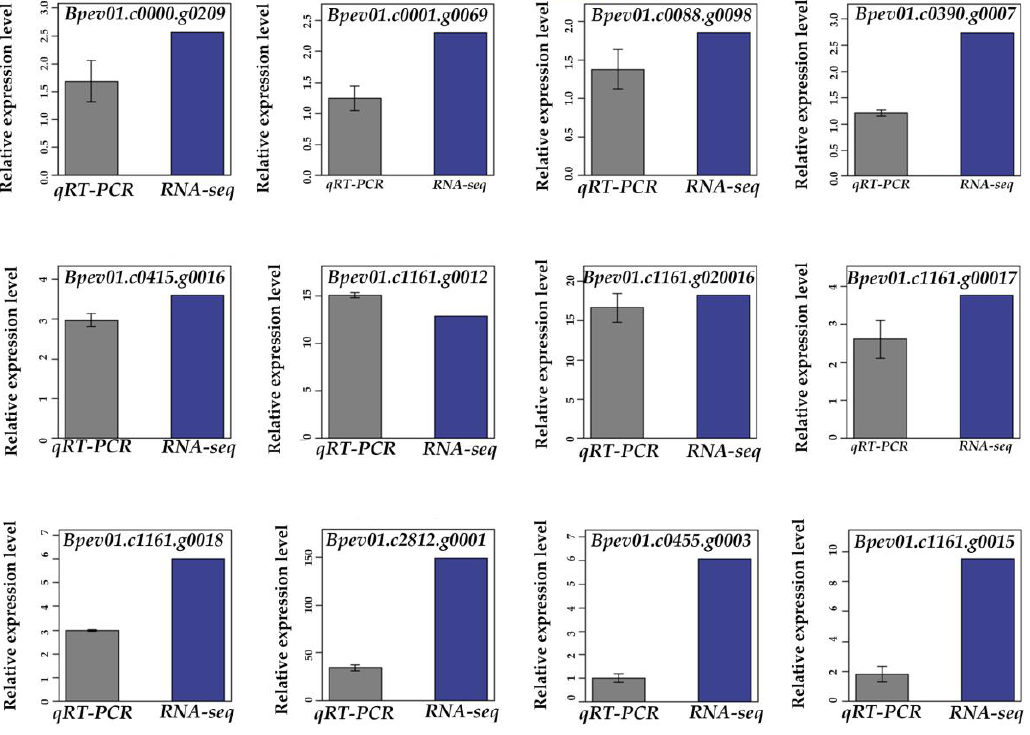
Figure 3. Validation of the RNA-Seq results by qRT-PCR. A total of 12 DEGs were selected for the validation.